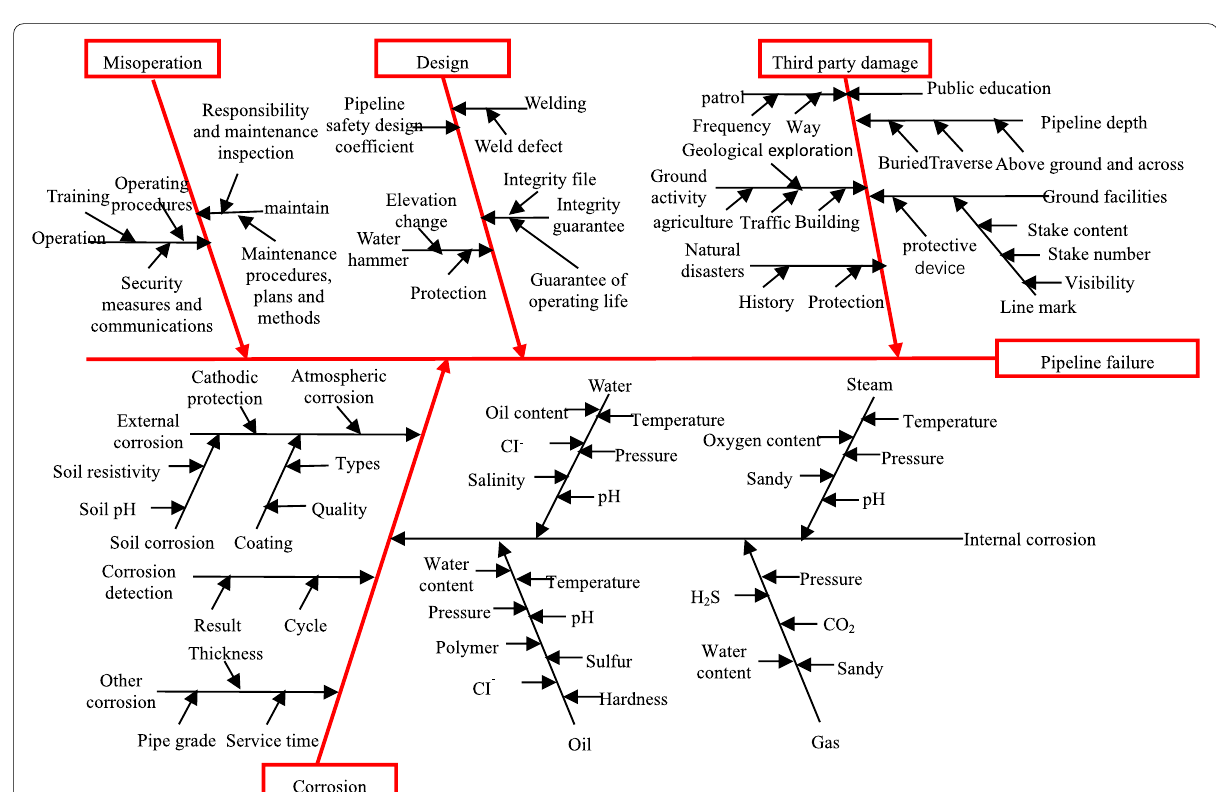
Fig. 2 Identification of hazard factors in gathering pipelines fishbone diagram. a Relationship between pressure and pipeline failure. b Relationship between sulfur and pipeline failure. c Relationship between salinity and pipeline failure. d Relationship between temperature and pipeline failure. e Relationship between CI- and pipeline